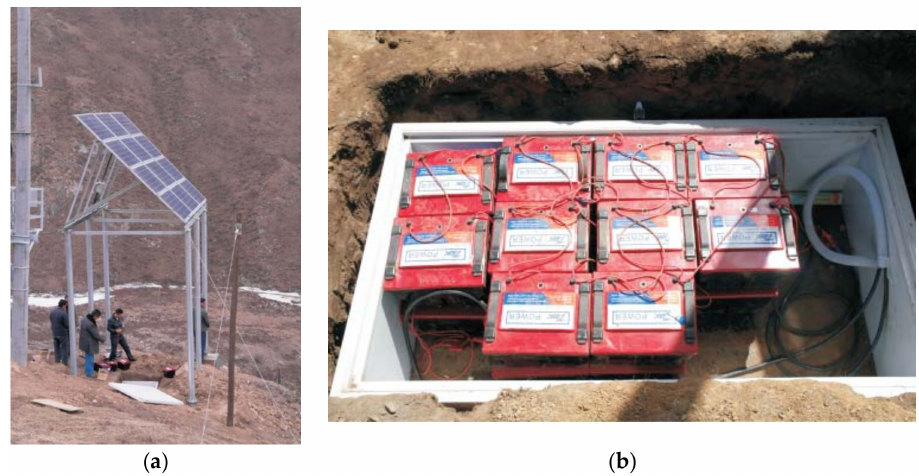
Figure 32. Example of Ni/MH batteries in alternative energy storage applications: ( a ) a solar cell system and ( b ) the accompanying Ni/MH battery pack installed and tested in Qinghai Plateau. (Courtesy of